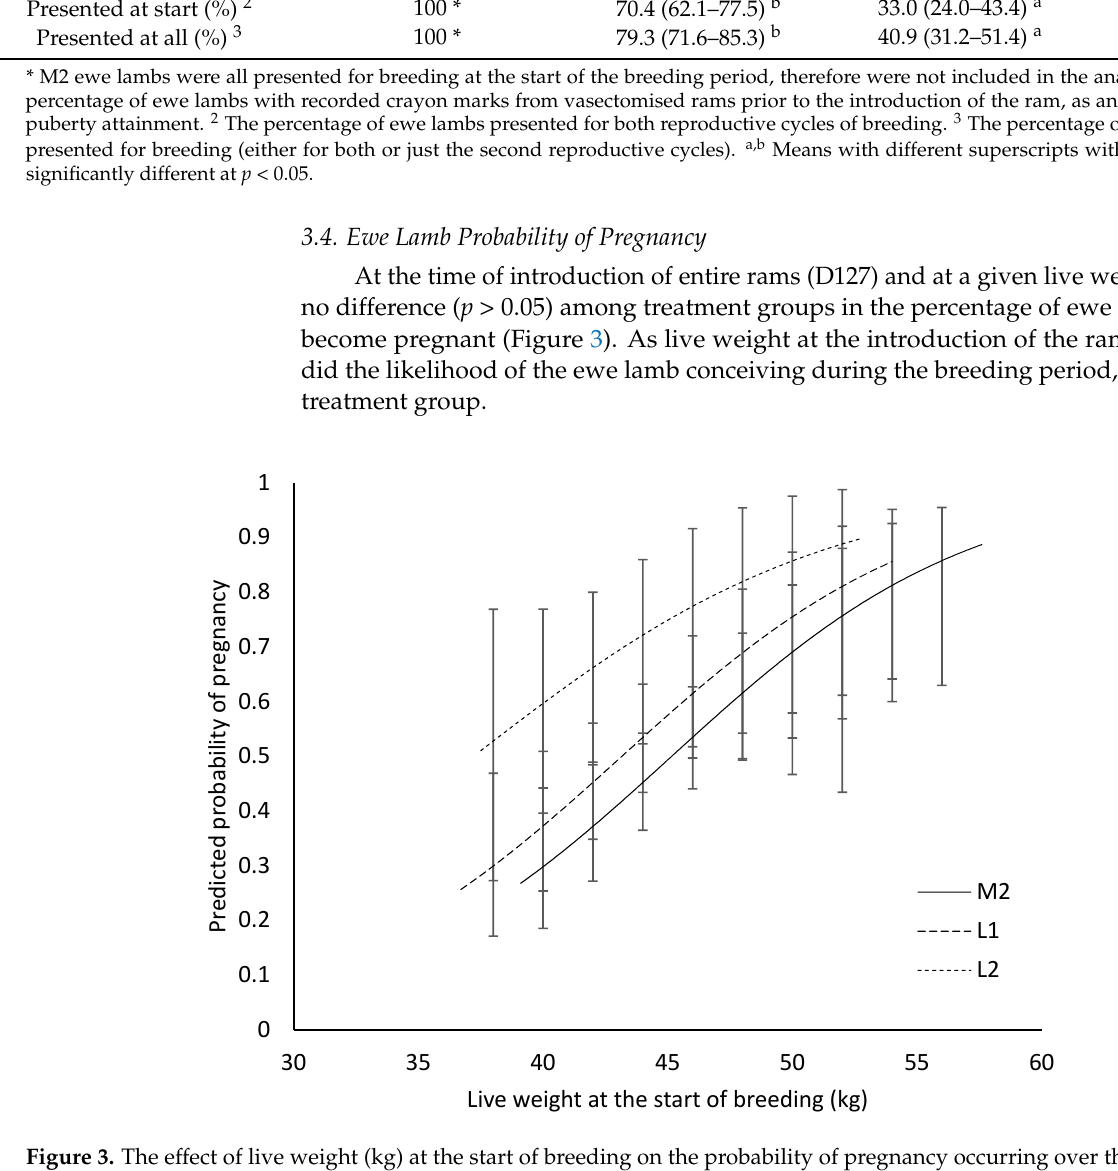
Figure 3. The effect of live weight (kg) at the start of breeding on the probability of pregnancy occurring over the breeding period, for the ewe lambs born to mature ewes as twins (M2; ― ), or born to ewe lambs as singletons (L1; – –) or as twins (L2; ---) during their first breeding. Values are back-transformed LS means and error bars are 95% confidence intervals.